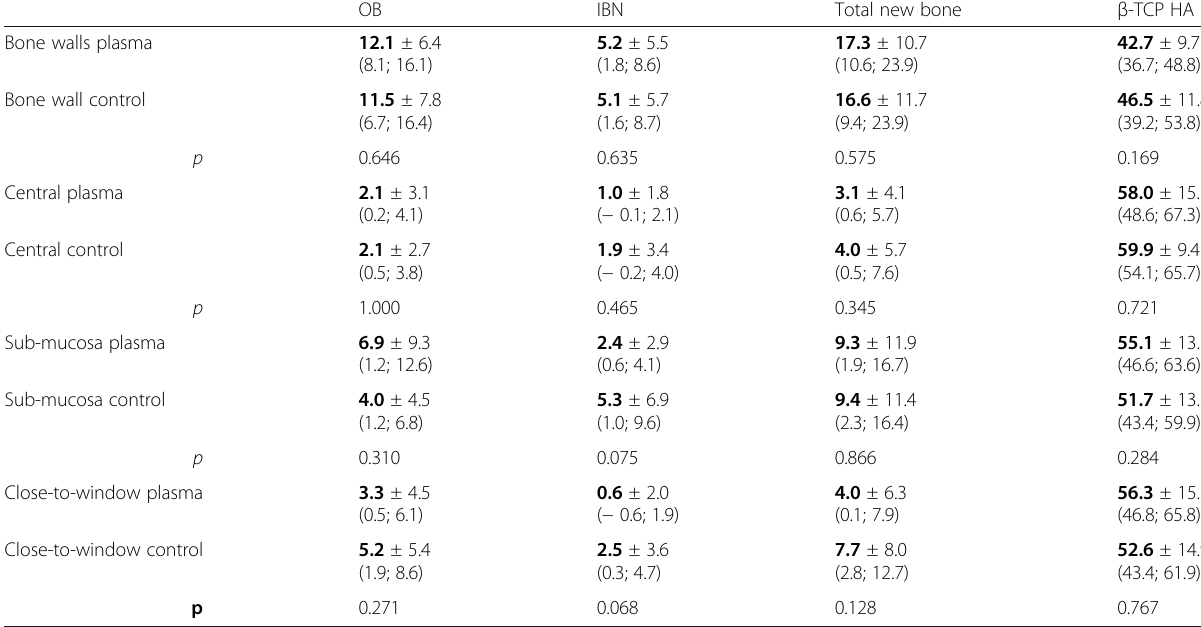
Table 2 Hard tissue components in percentages (%) in the various regions of the elevated area in the plasma and control sites after 2 weeks of healing. Mean values (in bold) ±standard deviation and 95% confidence interval (upper;